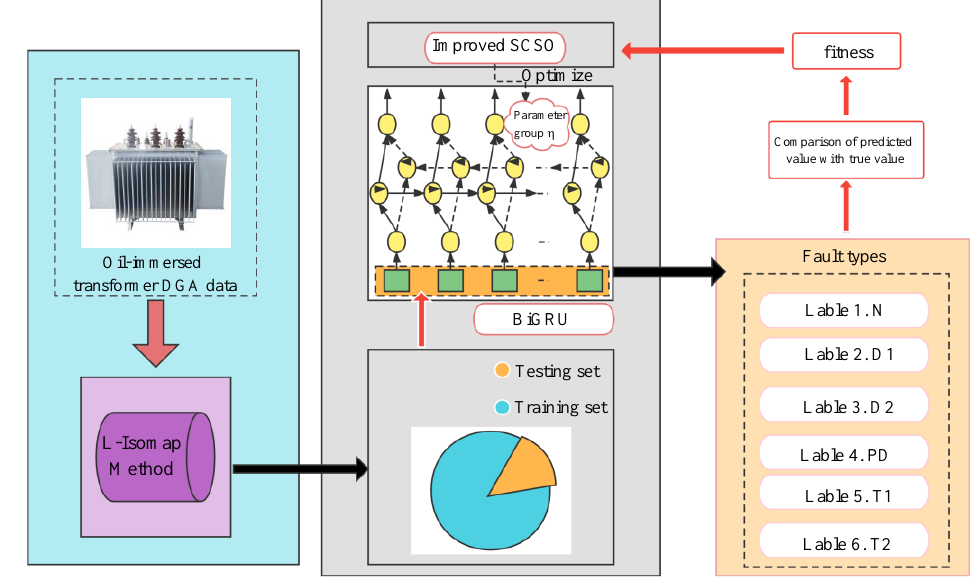
Figure 16. Implementation framework diagram of the model. Table 3. Parameters Settings.